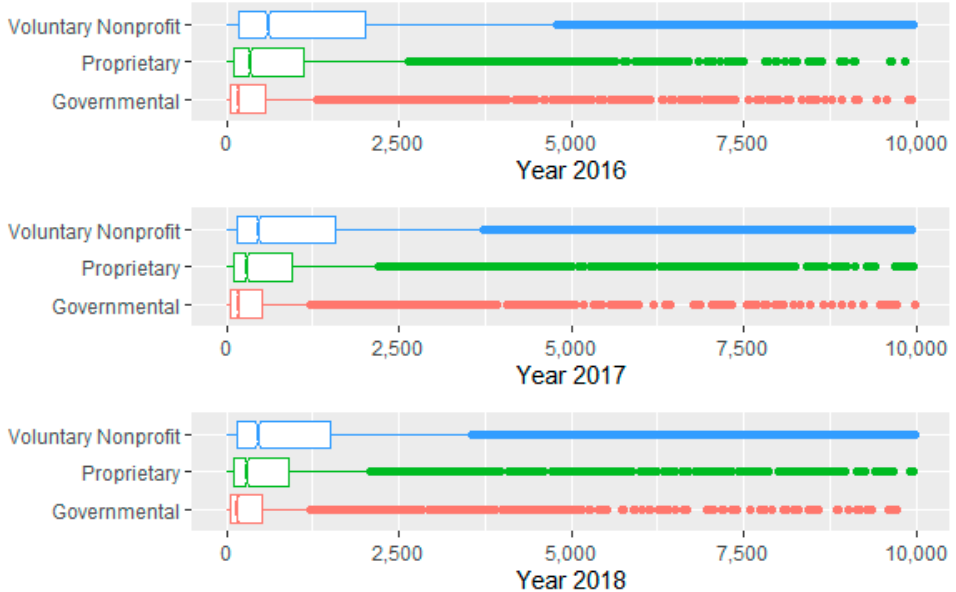
Figure 7. Number of diagnoses by year by medical school affiliation (some outliers omitted).